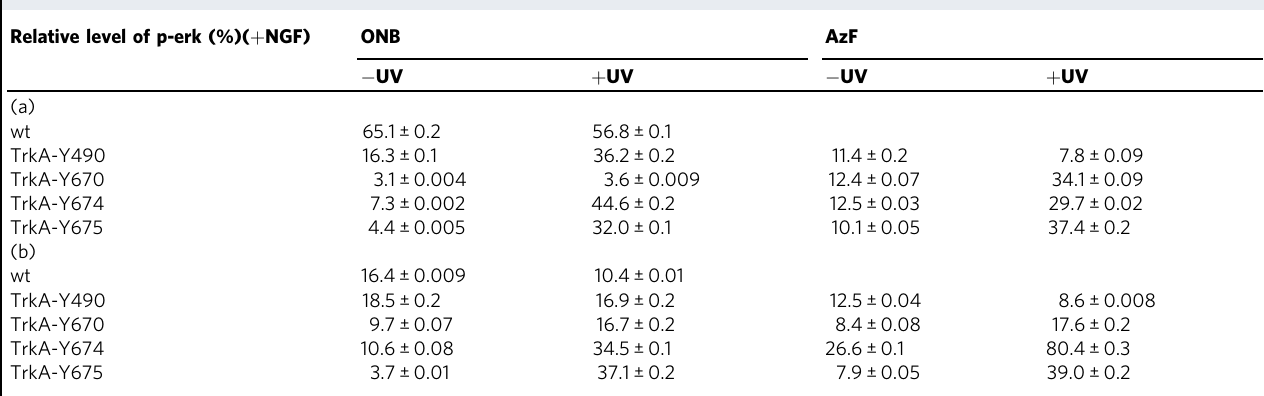
Table 1 All sites were detected under the same conditions as wt, and were repeated more than three times. Relative level of p-erk (%)( + NGF) ONB